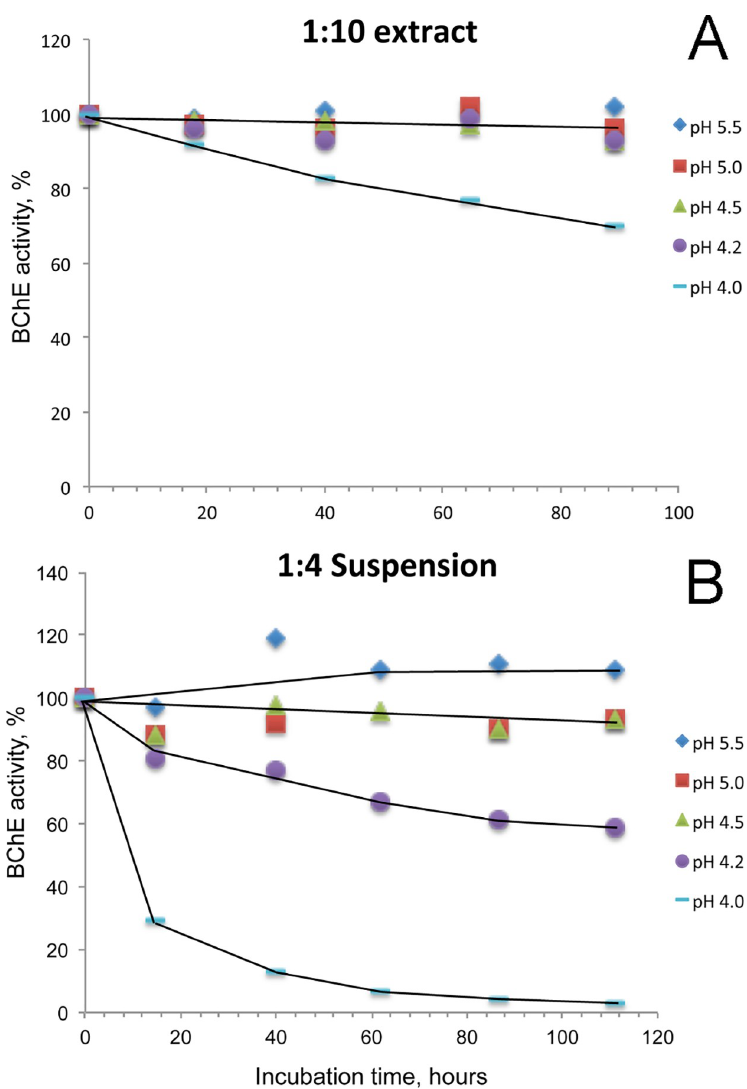
Fig 7. Stability of HuBChE activity in Cohn paste extracts as a function of pH and storage time. A) frozen paste extracted with 9 volumes of water, B) frozen paste extracted with 3 volumes of water. Extracts were stored at pH 5.5, 5.0, 4.5, 4.2, and 4.0 for 4 to 5 days at 5˚C and tested daily for BChE